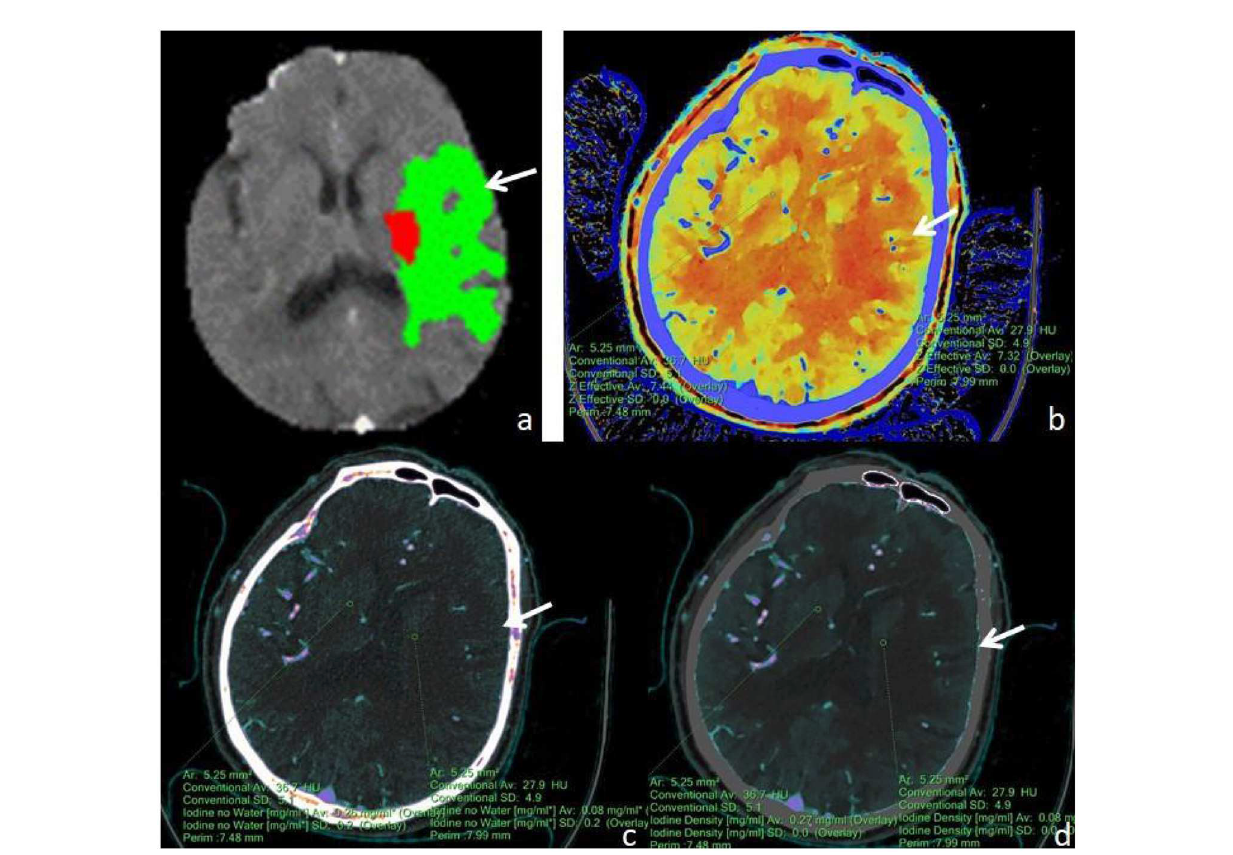
FIGURE3 A male, 71 years old, presented with sudden aphasia with right-sided limb movement deficit for 8h. (a) F-STROKE automated perfusion analysis software showed left temporal AIS with CBF < 30% = 6.7mL and Tmax > 6S = 109.7mL; (b–d) Zeff maps, iodine density maps, and absolute iodine maps, respectively, with arrows indicating ischaemic areas in the left temporal lobe. (b) A Zeff value of about 7.32 was measured in the ischaemic region in the left temporal lobe, while a value of about 7.44 was measured in the contralateral non-ischaemic region. (c) An iodine–no-water value of approximately 0.08 mg/mL was measured in the ischaemic area of the left temporal lobe, and a corresponding absolute iodine value of approximately 0.26 mg/mL was measured in the contralateral non-ischaemic area. (d) An iodine density value of approximately 0.08 mg/mL was measured in the ischaemic area of the left temporal lobe, and a corresponding iodine density value of approximately 0.27 mg/mL was measured in the contralateral non-ischaemic